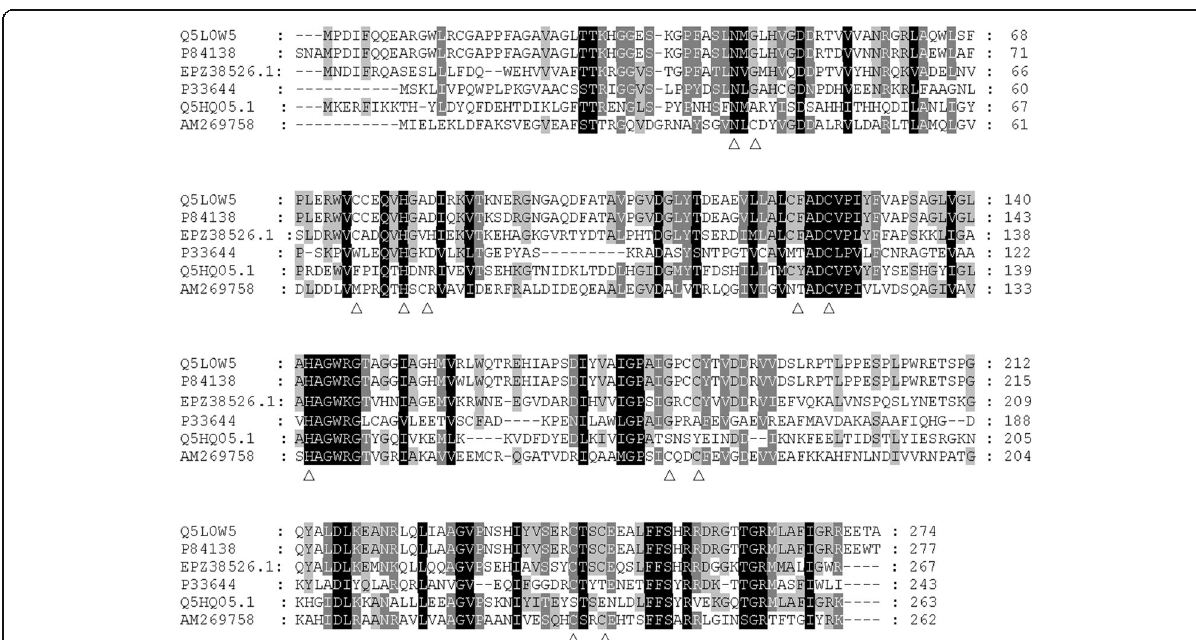
Fig. 1 Multiple sequence alignment of LacAn with selected LacAn-related proteins. Amino acid sequences were retrieved from NCBI or the UniProt database. LacAn, a copper oxidase in this study (GeneBank accession no. EPZ38526.1); yfiH, a laccase from E. coli (UniProt accession no. P33644); 1t8h (UniProt accession no. P84138), Q5HQ05.1, Q5L0W5 were uncharacterized proteins from Bacillus stearothermophilus , Staphylococcus epidermidis RP62A , and Geobacillus kaustophilus ; RL5, a laccase from the bovine rumen metagenome (NCBI accession no. AM269758). The amino acid residues binding to the three copper sites in RL5 are indicated with